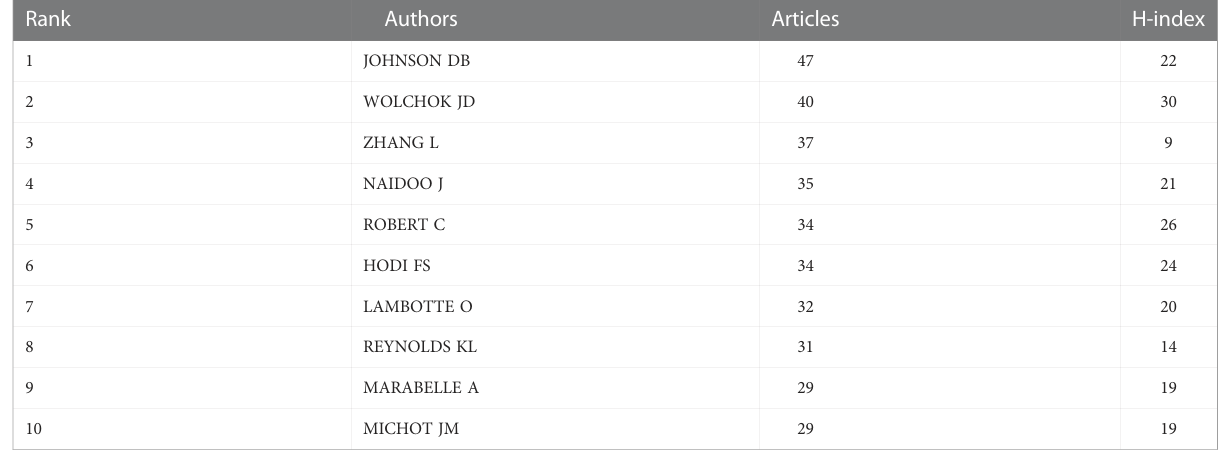
TABLE 2 Top 10 authors with the most publications in the fi eld of immune-related adverse events.